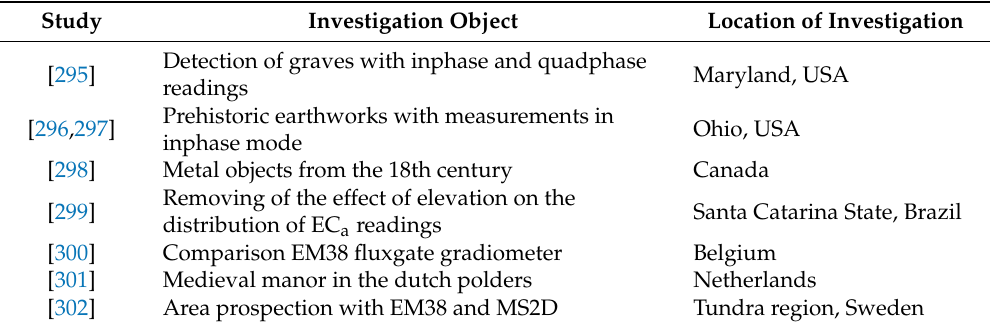
Table 11. Additional applications of EM38-EC a in